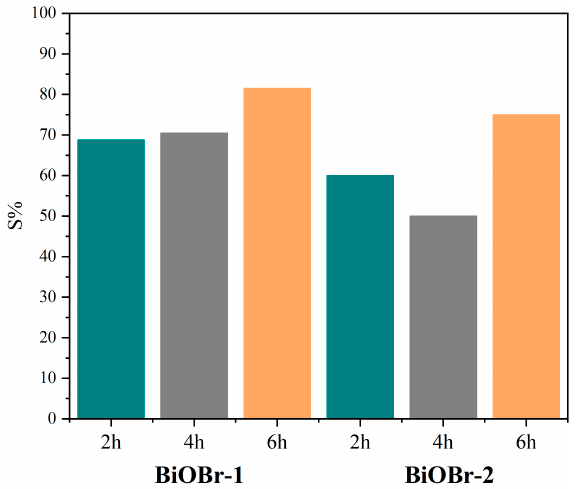
Figure 3. The nitrate selectivity of modified samples with different autoclaved curing time.